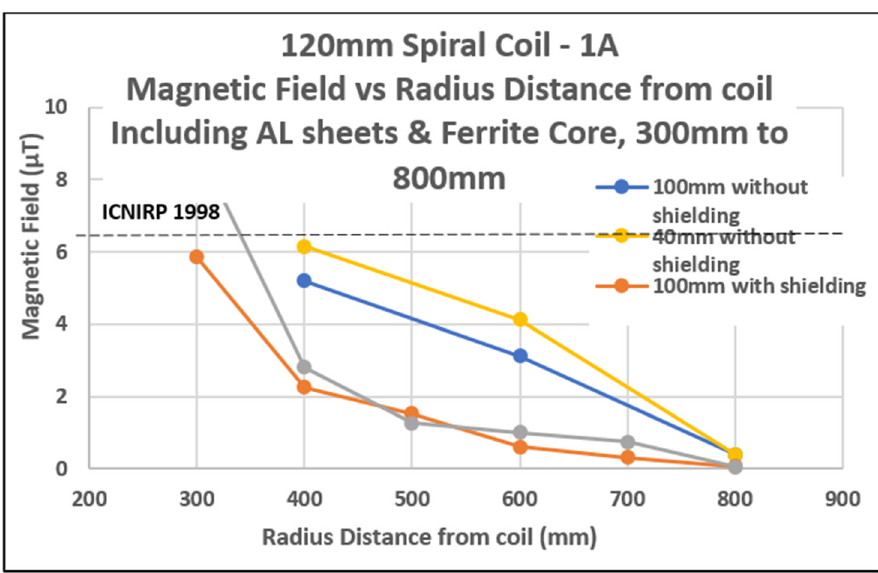
Figure 14. Reduced magnetic field exposure rates vs. radial distance away from coils: ( a ) 120 mm spiral coil excited by 1 A current; ( b ) 600 mm spiral coil excited by 8 A current.